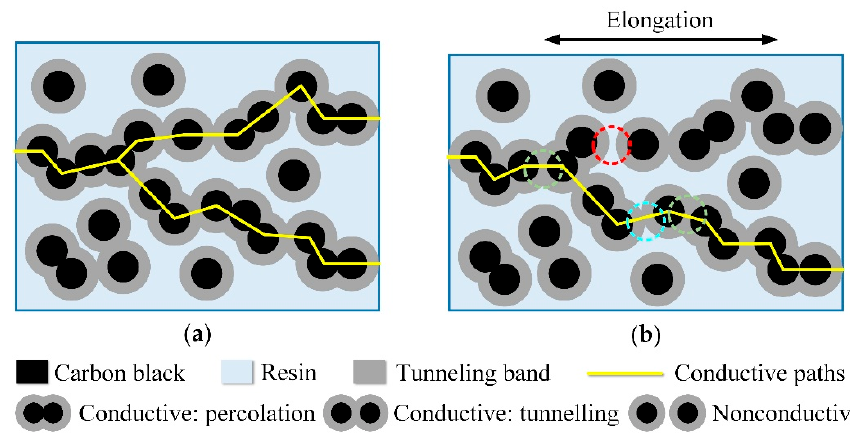
Figure 5. The conductive mechanism and piezoresistive mechanism of the carbon paste-based strain gauge from a micro perspective: ( a ) Without the load; ( b ) Being stretched. The red, blue and green dashed circles emphasize the changes in the spacing between carbon black particles.